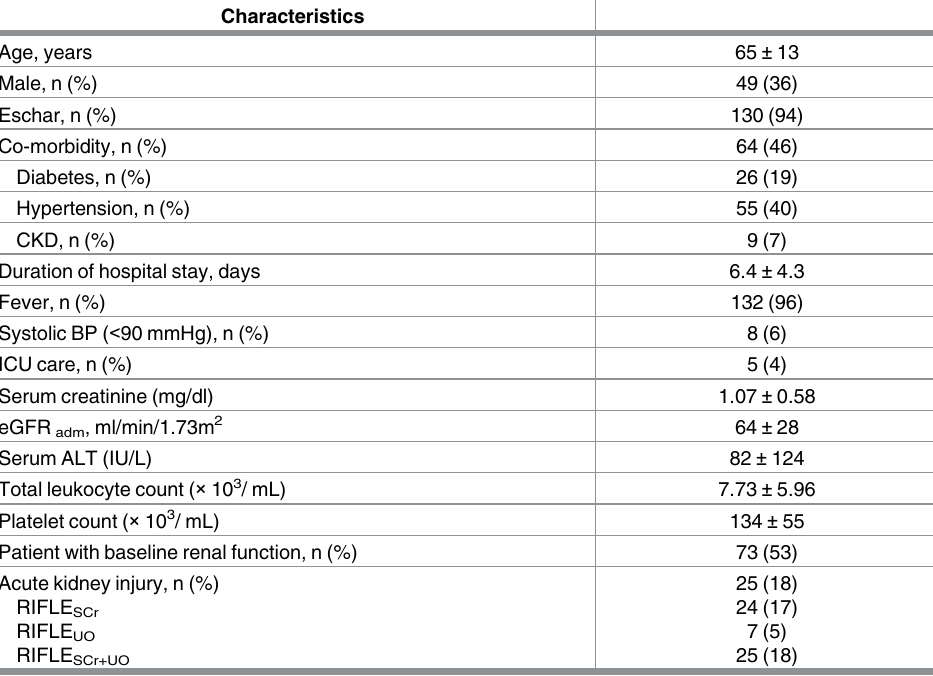
Table 1. The clinical and laboratory findings of the 138 patients with scrub